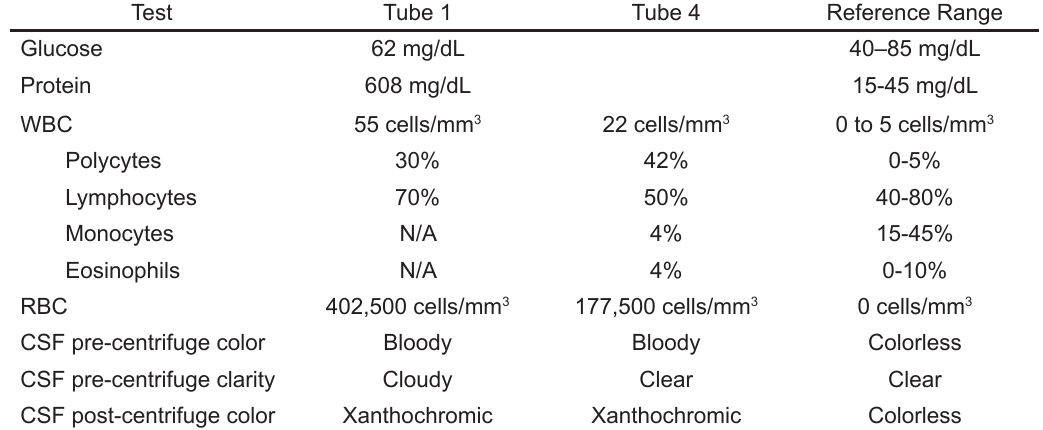
Table 2. Cerebral spinal fluid results of a 58-year-old male presenting with a headache, hand numbness, and phantosmia. Tube 1 is the first tube obtained during lumbar puncture; Tube 4 is the last tube obtained during lumbar puncture.